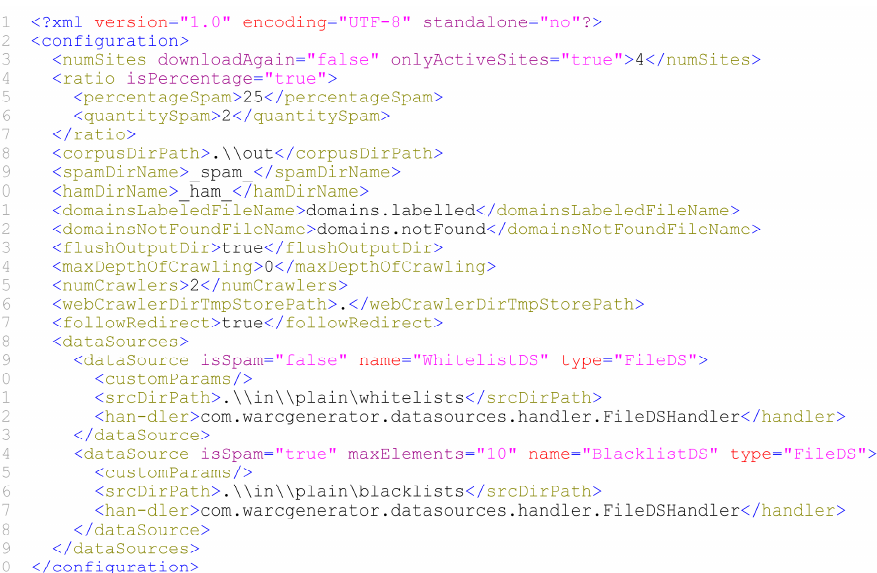
Figure 7. Snippet of a valid WARCProcessor configuration file.